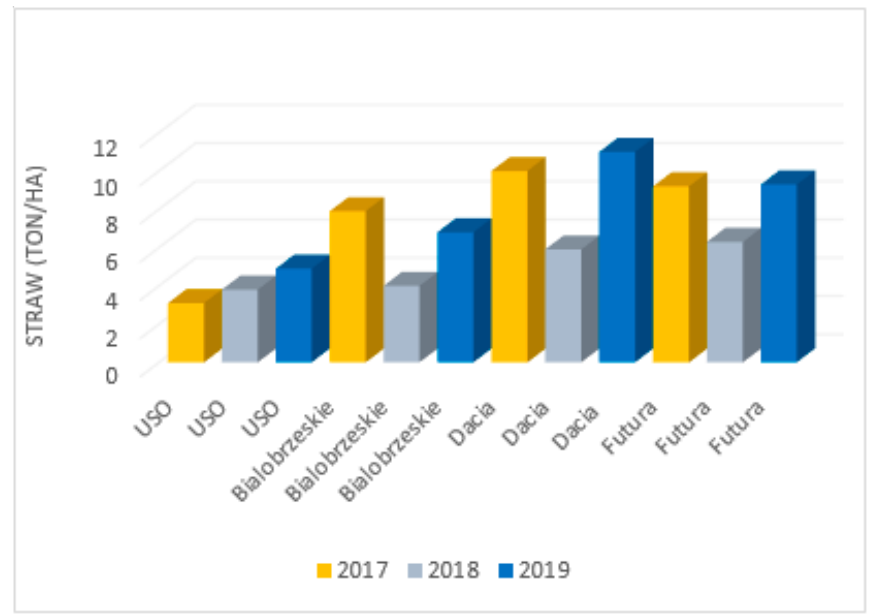
Figure 11. Mean straw yield determined for different type of hemp cultivars: USO 31, Dacia Secuieni, Bialobrzeskie, Futura 75, cultivated for three consecutive years, based on